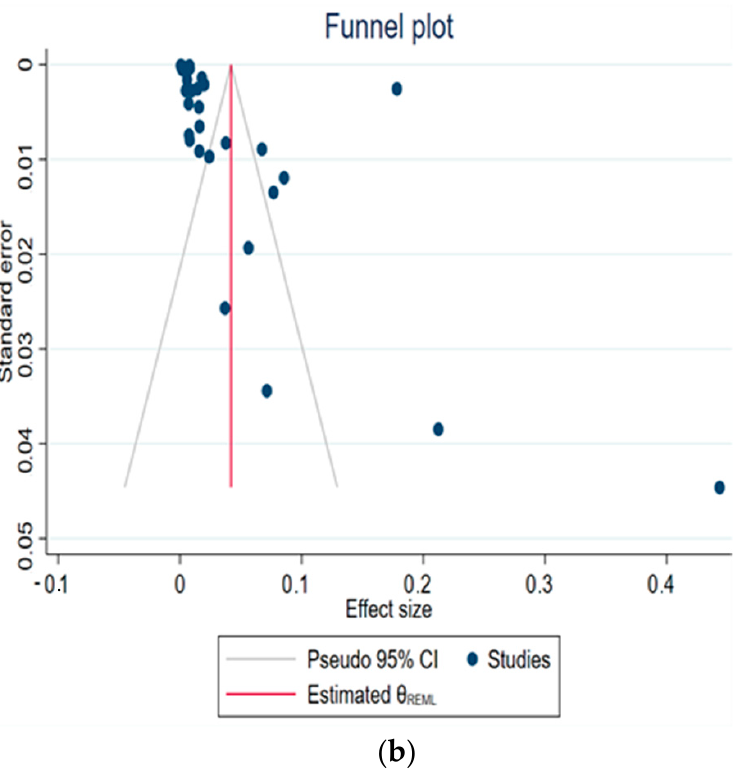
Figure 2. ( a ) Pooled prevalence of PLWH among COVID-19 cases. The red dotted line represents the overall effect size. The lateral edges of the blue diamonds represent the limits of the 95% confidence intervals (ES: effect size; CI: confidence interval). ( b ) Funnel plot of studies pooled for the prevalence of PLWH among COVID-19 cases (ES: effect size; se: standard